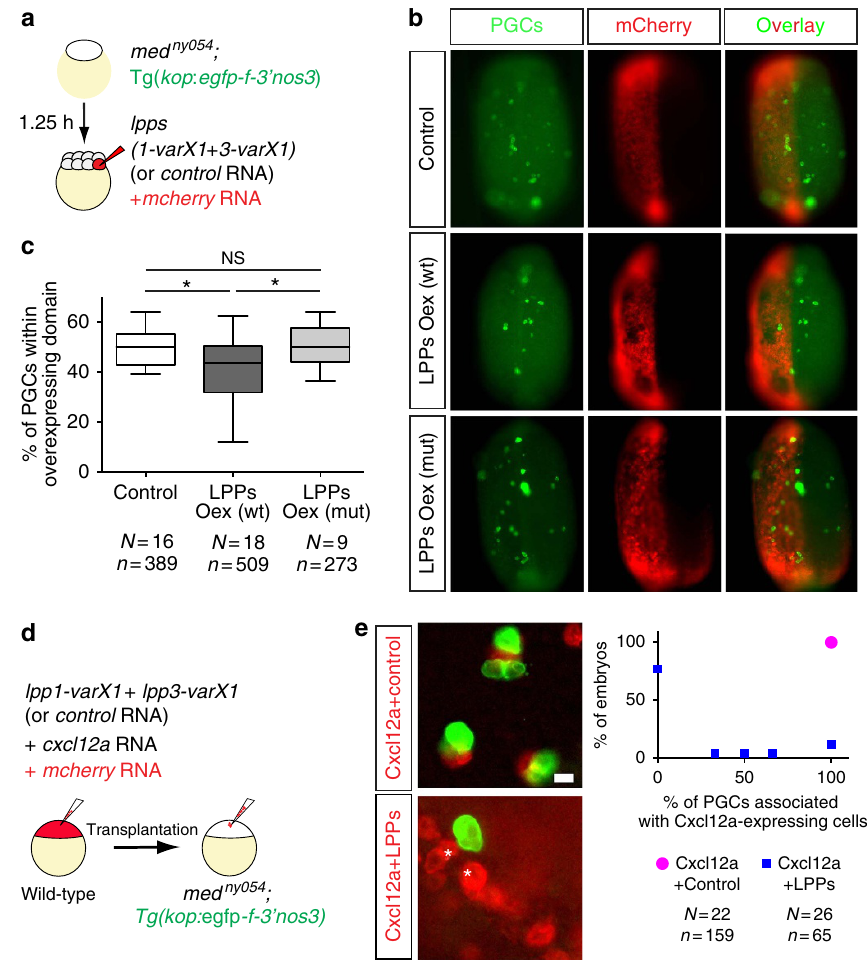
Figure 4 | PGCs avoid regions expressing LPP proteins. ( a ) Generation of embryos lacking Cxcl12a, whose PGCs are labelled by EGFP and overexpress either LPP proteins or a Control protein in mCherry-labelled half of the embryo. ( b ) PGCs avoid cellular domains of the embryos, which overexpress LPPs (middle row), as compared to control domains (top row) or those overexpressing phosphatase-inactive versions of LPPs (lower row). ( c ) A significant reduction in the percentage of PGCs located within the LPPs-overexpressing domain in 10hpf embryos (one-way analysis of variance; * P r 0.05). Error bars designate minimum to maximum range of the data points. N and n show the number of embryos and PGCs, respectively. See also Supplementary Fig. 8. ( d ) mCherry-labelled cells overexpressing Cxcl12a with either a Control Protein or LPPs were transplanted into embryos lacking Cxcl12a ( med ny054 ) whose PGCs express EGFP. ( e ) Images and a graph demonstrating the association of PGCs with Cxcl12a-expressing cells in control embryos (upper image, magenta point in graph) and the lack of interaction with cells expressing Cxcl12a and LPPs (starred red cells in lower image, blue points in graph, 77% of embryos showed absolutely no cell association). The statistical significance was evaluated using the Mann–Whitney U -test (**** P r 0.0001). Scale bar, 15 m m. See also Supplementary Movie 3 and Supplementary Fig.